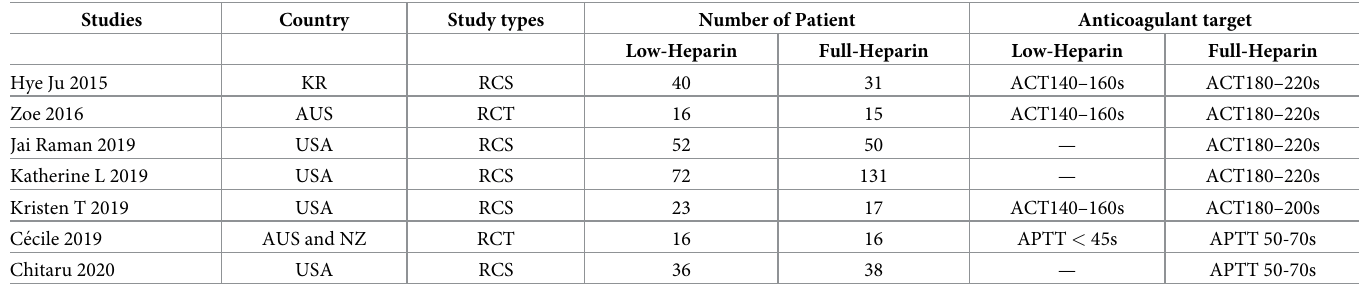
Table 1. Characteristics of the included